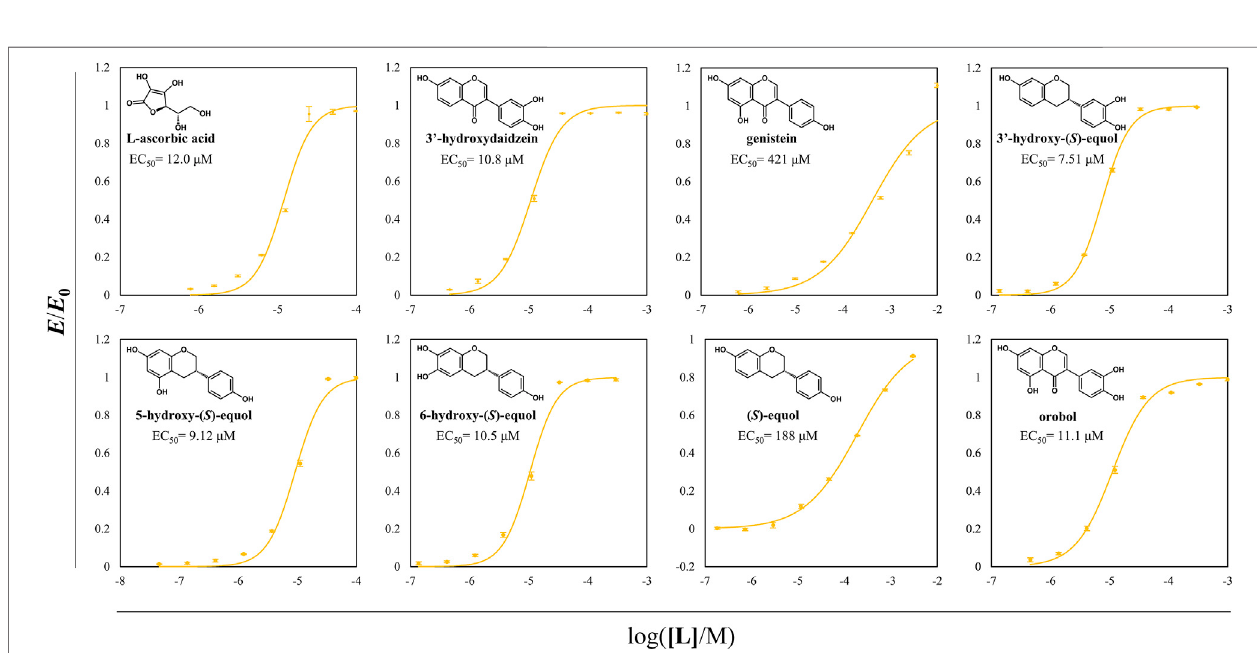
FIGURE 7 | ER-SRC1 agonistic Y2H assay of equol derivatives and the other estrogenic compounds. ß -galactosidase activity of yeast L40 cells harboring ER α (or ER β ) LBD hybrid and tSRC1 hybrid protein was assessed. The normalized responses of ER α -SRC1 and ER β -SRC1 interaction were expressed as blue and orange circles, respectively. The lines with two different colors were the regressed values. The inward table is the summary of EC 50 s, ε s, and β / α ratios of each compounds. All the data were recorded using mean values with standard deviations for triplicates.